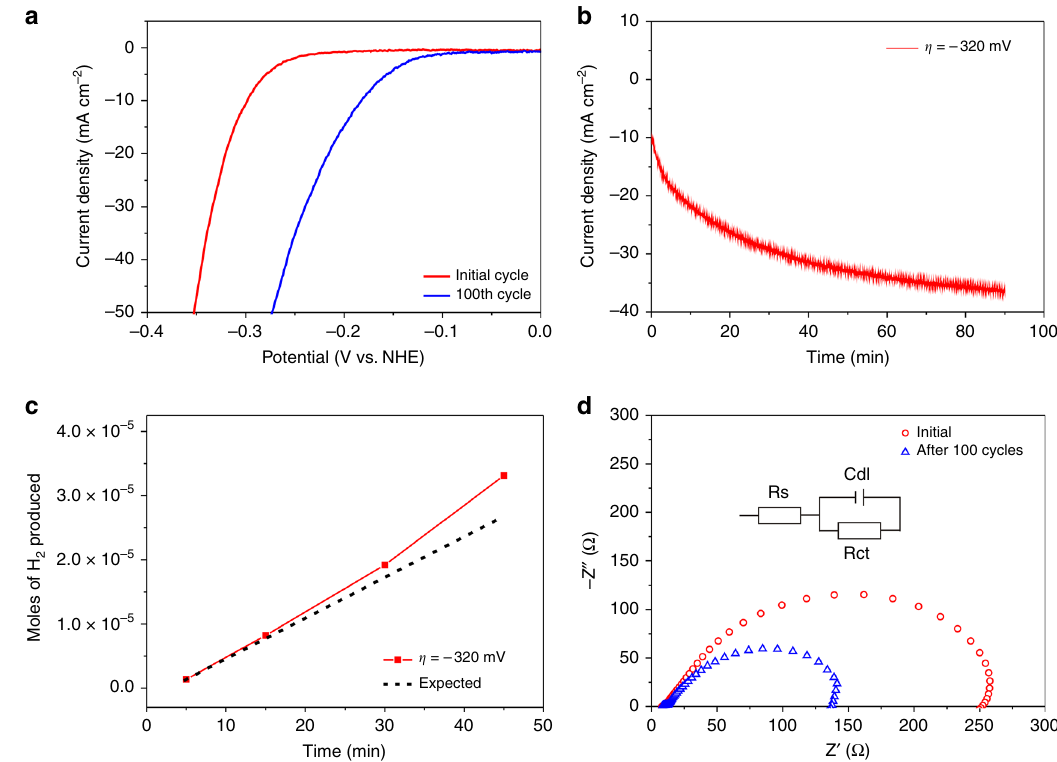
Fig. 2 Electrochemical studies of nanocrystalline 1T ′ -MoTe 2 . a Comparison of the current densities achieved by nanocrystalline 1T ′ -MoTe 2 before and after 100 cycles in 1 M H 2 SO 4 . Catalysts were prepared on a glassy carbon working electrode as described in the experimental section. Carbon felt and 3 M Ag/ AgCl were used as the counter and reference electrodes, respectively. b Chronoamperometry pro fi les of the catalyst in 1 M H 2 SO 4 . The applied potential was chosen by initially performing LSV and choosing the potential corresponding to j = − 10 mA cm − 2 . Experiments were performed using a three electrode setup, with catalyst-deposited glassy carbon as the working electrode, 3 M Ag/AgCl as the reference and carbon felt as the counter electrode. c Representative trace of the number of moles of hydrogen produced with time as a constant potential is applied. The applied potential was chosen from LSV and corresponded to j = − 10 mA cm − 2 . Solid line indicates the experimentally determined value of hydrogen yield from gas chromatography for